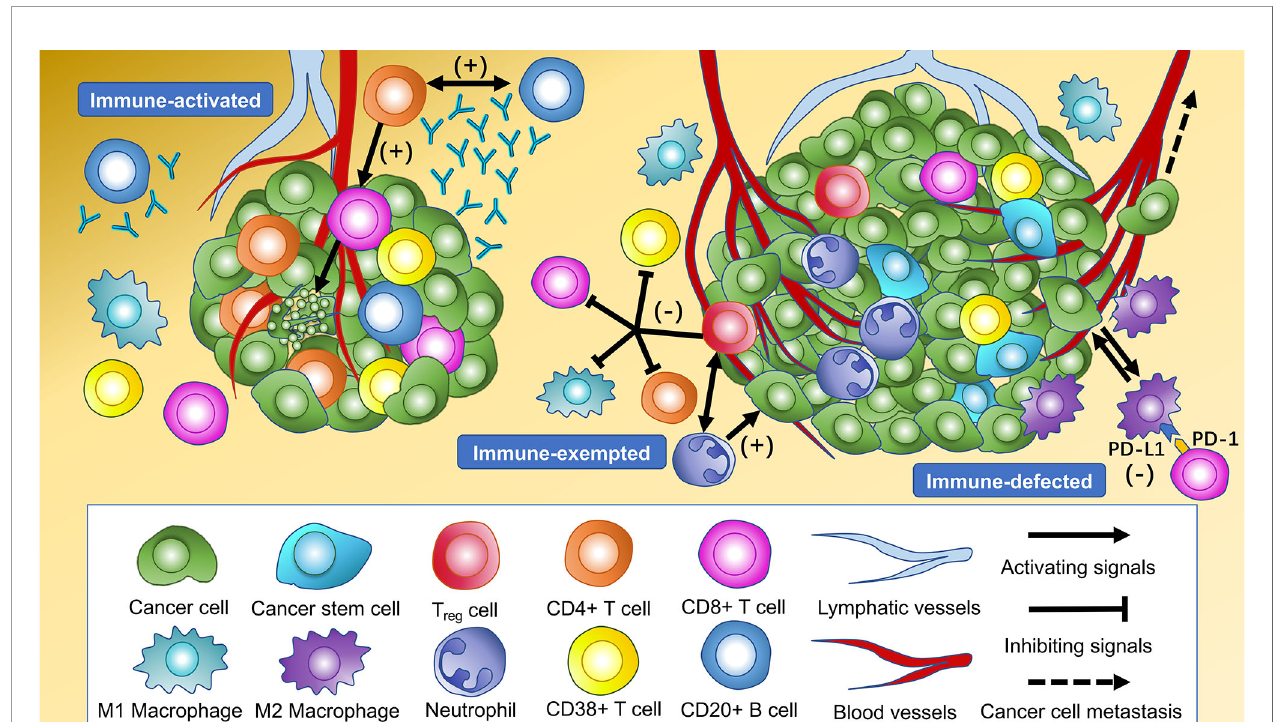
FIGURE 4 | Cellular features of immune subtypes in the tumor immune microenvironment of non-small cell lung cancer (NSCLC). The immune-activated subtype is characterized by the highest levels of intratumoral and intrastromal CD4+ T cells, intrastromal CD20+ B cells, and intratumoral CD8+ T cells. CD20+ B cells present tumor antigens for activating CD4+ cells, and CD20+ B cells proliferate and differentiate into plasma cells to generate antibodies for antineoplastic effects with the help of cytokines secreted by CD4+ cells. The CD8+ T cells activated by CD4+ cells tend to kill the cancer cells in the tumor core directly. The highest levels of intratumoral and intrastromal regulatory T cells (Tregs) and neutrophils were observed in the immune-exempted subtype. Tregs produce immunosuppressive molecules which inhibit the activation and function of CD4+ T cells, CD8+ T cells, CD38+ T cells, and M1 macrophages to disrupt immune surveillance and promote tumor progression. Tregs may also recruit neutrophils through the chemokine ligand – chemokine receptor pathway. The immune-defected subtype has the highest levels of intratumoral and intrastromal cancer stem cells (CSC) and intratumoral macrophages. The macrophages in the immune-defected subtype are educated by the CSC to obtain pro-tumorigenic functions like angiogenesis and induce the exhaustion of anti-tumor cells. The immune-exempted and immune-defected subtypes are associated with a more advanced-stage NSCLC than the immune-activated